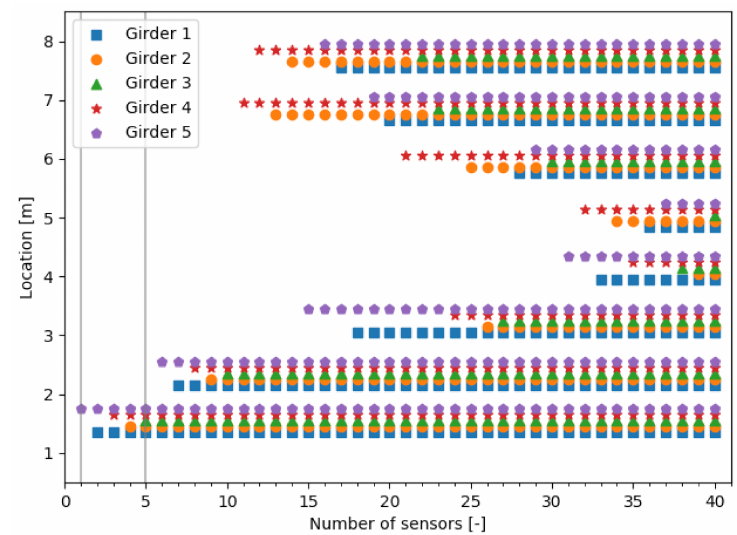
Figure 5. Optimal sensor placement considering the first four modes and no correlation between the sensor locations. The two vertical lines support the explanation on how to read the figure.